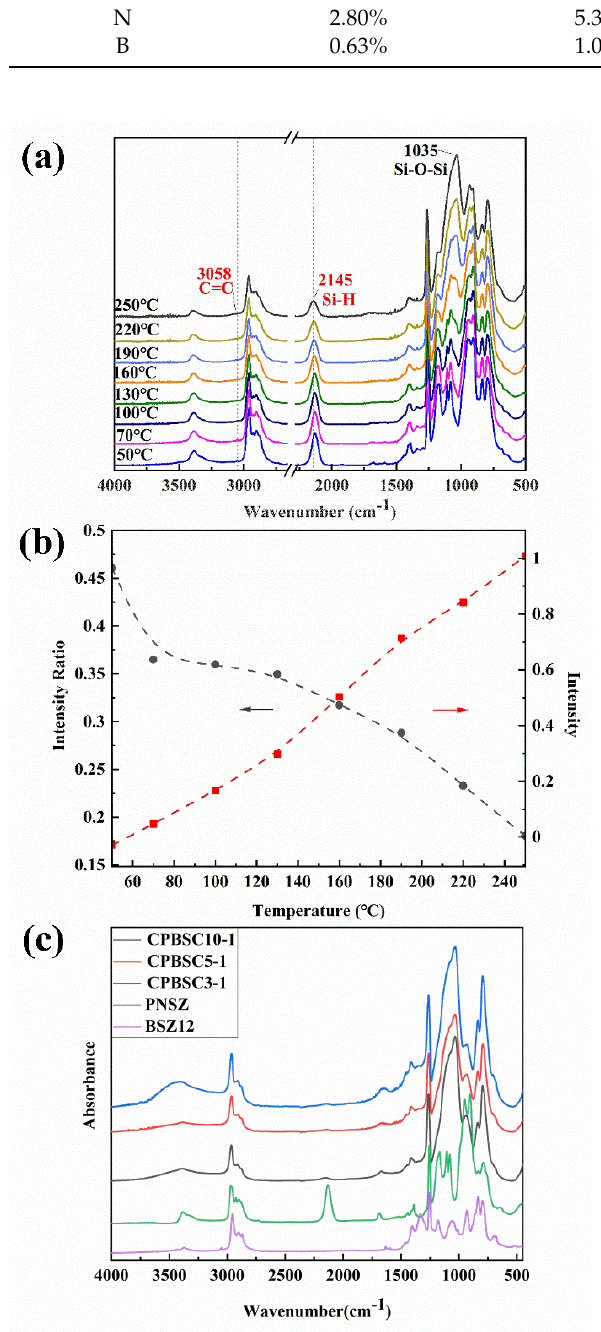
Figure 3. ( a ) FTIR spectra of CPBCS cured at different temperature for 2 h; ( b ) Peak intensity ratio of 2138 over 1260 cm −1 (gray), and 1035 over 1260 cm −1 (red) as a function of curing temperature; ( c ) FTIR spectra of CPBCS solids, BSZ12 and PNSZ were used to monitor the reaction. Si-H intensity decreased with temperature due to hydrosilylation consumption. (Figure 3b) The appearance of Si-O-Si (1035 cm −1 ) was due to the oxygen participation in the hydrosilation reaction, and the intensity increased with temperature. The formation